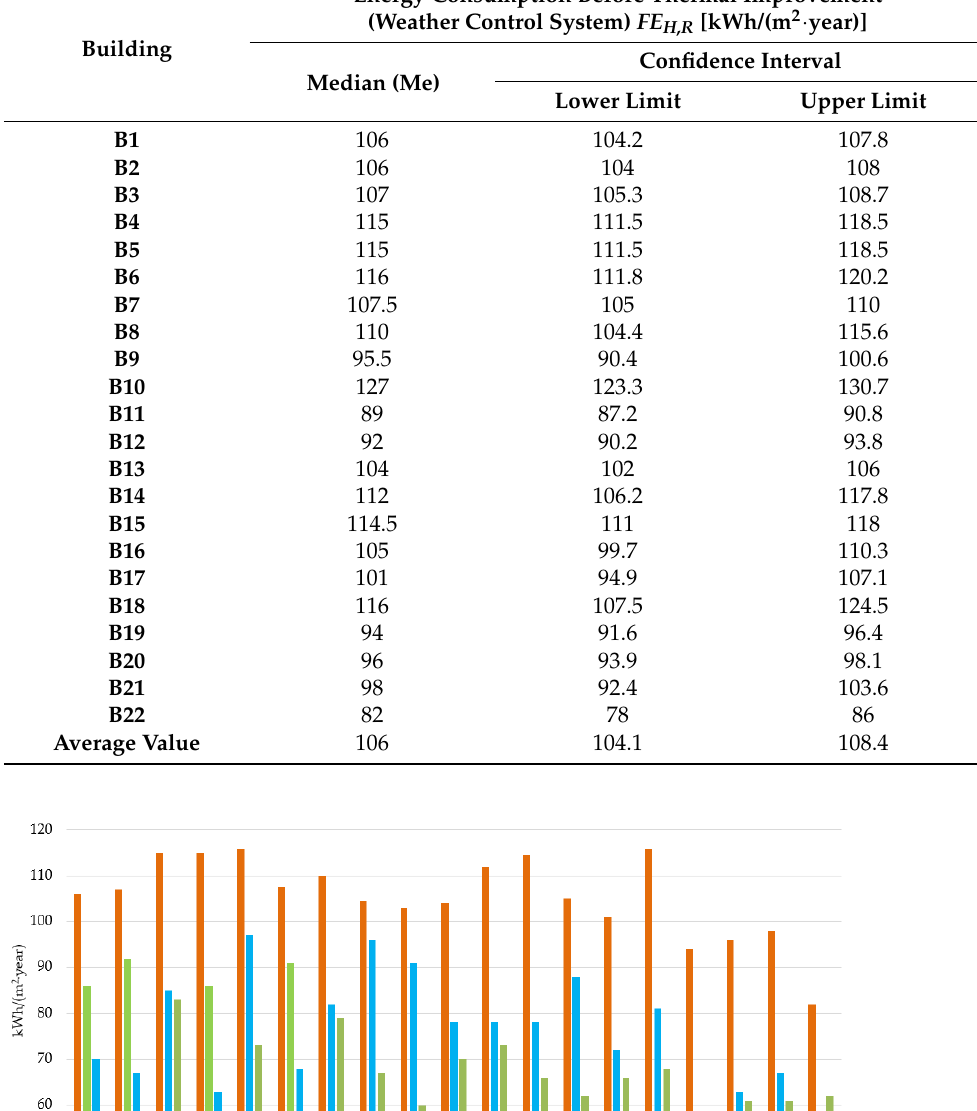
Table 5. Energy consumption in buildings B1–B22 before thermal improvement; weather control is